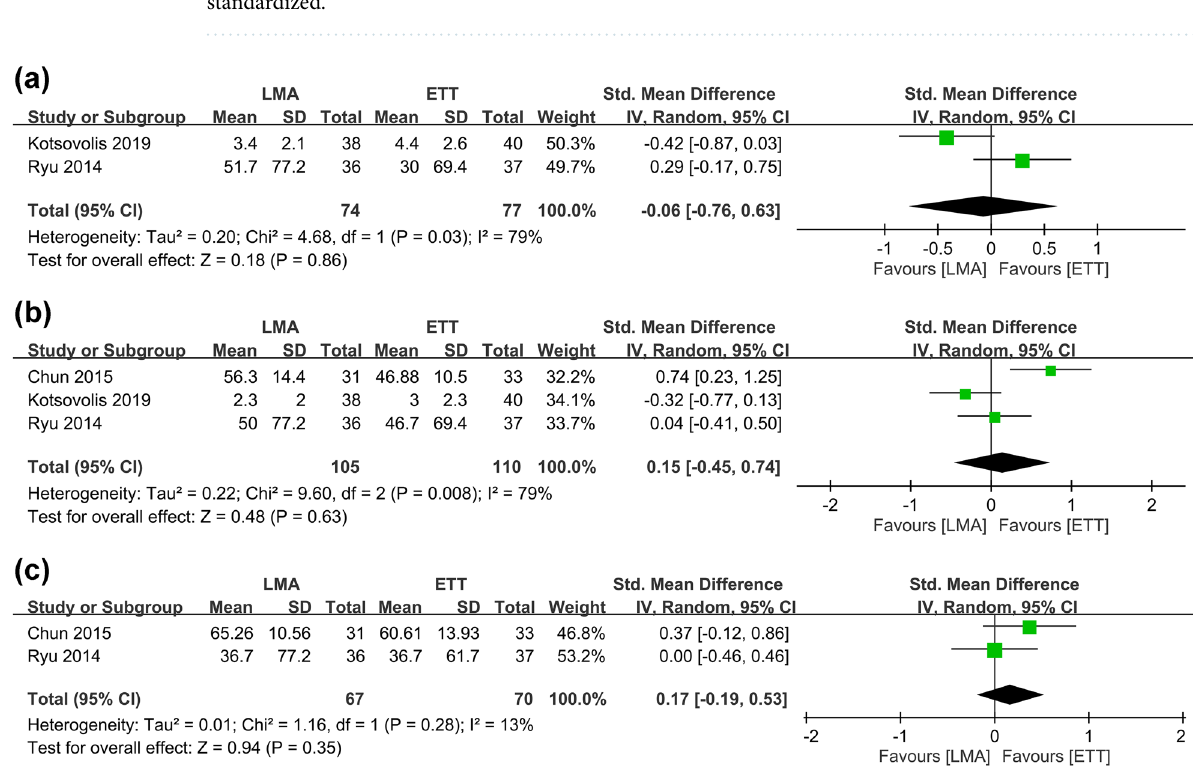
Figure 6. Forest plot comparing the severity of hoarseness at ( a ) 1 h, ( b ) 24 h, and ( c ) 48 h between laryngeal mask airway (LMA) and endotracheal tube (ETT) groups. CI confidence interval, IV inverse variance, Std standardized.